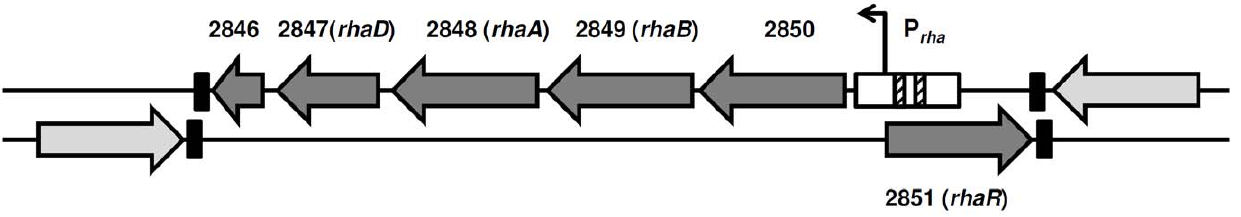
Figure 1. The L.monocytogenes rhamnose utilization operon. Dark grey: open reading frames lmo2846-lmo2851 located on both DNA strands [9] and their functional assignments; white: P rha promoter, putative -10 and -35 regions are shaded; black: transcription